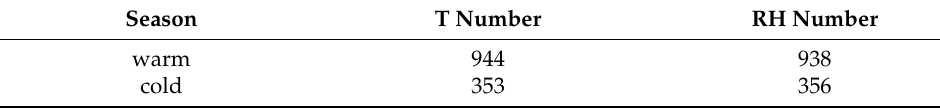
Table 3. Number of Collocated RAOB Datasets.